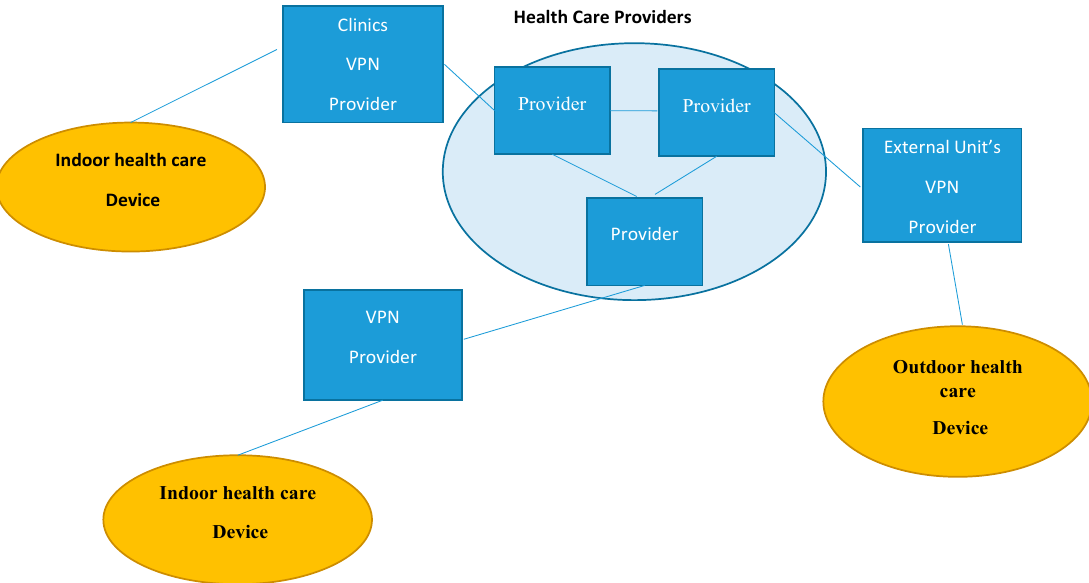
Figure 3. VPN in an IP domain and remote healthcare monitoring system.